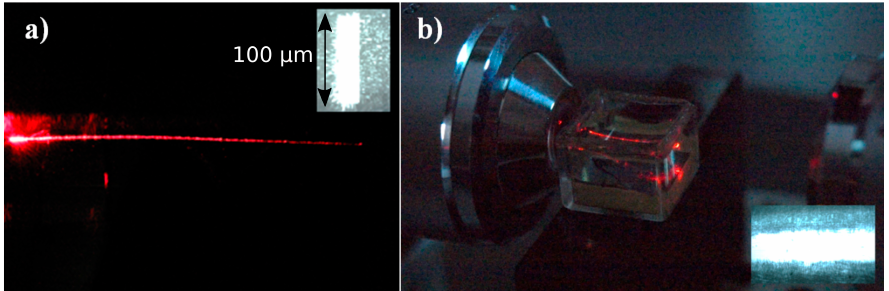
Figure 2. Top-view imaging of a 100 µm wide waveguide positioned on PDMS plots during laser light injection and propagation (λ = 670 nm), ( a ) in air, ( b ) immerged in silicon oil. The insets show the light confinement recorded on the CCD camera at the output of the